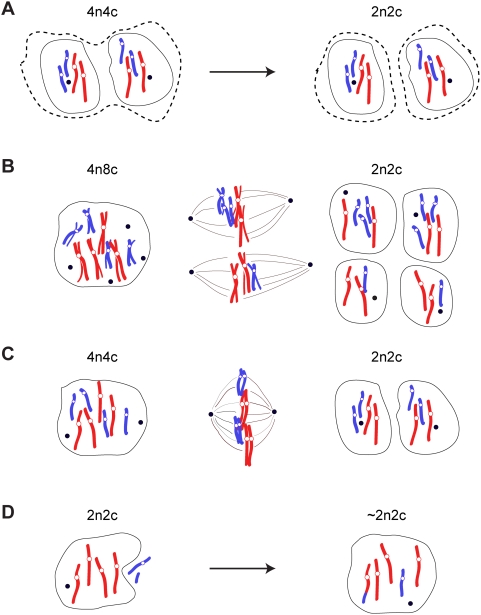
Potential mechanisms for diploid hepatocyte formation from polyploid fusion-derived hepatocytes.(A) Cytokinesis without mitosis. A binucleated cell undergoes cytokinesis before entering the next cell cycle. This process would not produce marker loss or aneuploidy. (B) Multiple spindles, followed by multipolar (in this case tetrapolar) mitosis. Extreme aneuploidy would result. (C) Mitosis without S-phase with chromosome pairing. This would ensure proper chromosome segregation and would facilitate distribution of hemizygous markers between daughter cells. (D) Horizontal gene transfer. A diploid cell engulfs a neighboring cell undergoing apoptosis. Single chromosomes and/or chromosome fragments would be incorporated into the nucleus while maintaining a nearly diploid karyotype. The parental cell is shown at left, mitotic spindle(s) (when necessary) in the middle and resulting diploid cells on the right. Open circles represent centromeres. Black circles represent centrosomes. Chromosomes are shown in different colors to indicate their lineage. Host hepatocyte chromosomes are red, and donor chromosomes are blue.